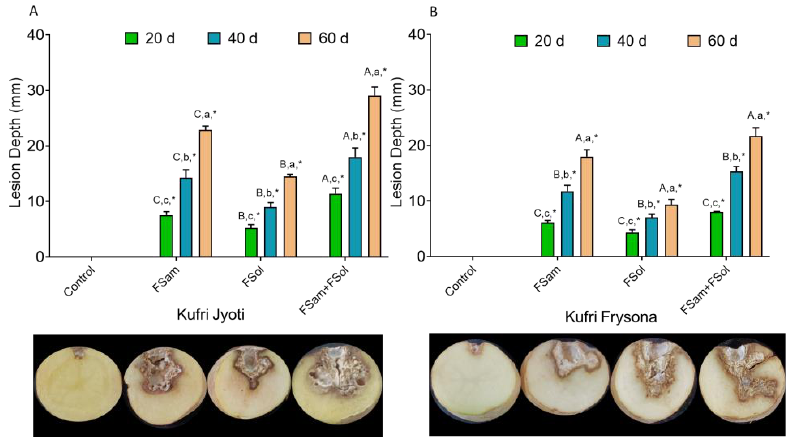
Figure 3. The figure represents the effect of dry rot infection on lesion depth on ( A ) Kufri Jyoti ( B ) Kufri Frysona; control, no pathogen infection; FSam, Fusarium sambucinum ; FSol, Fusarium solani ; FSam + FSol, Fusarium sambucinum + Fusarium solani . Capital letter = significance of inoculum (within one date/cultivar combo); Lower case letter = significance of date (within one inoculum/cultivar combo); * = significance between cultivars (within one inoculum/date combo).